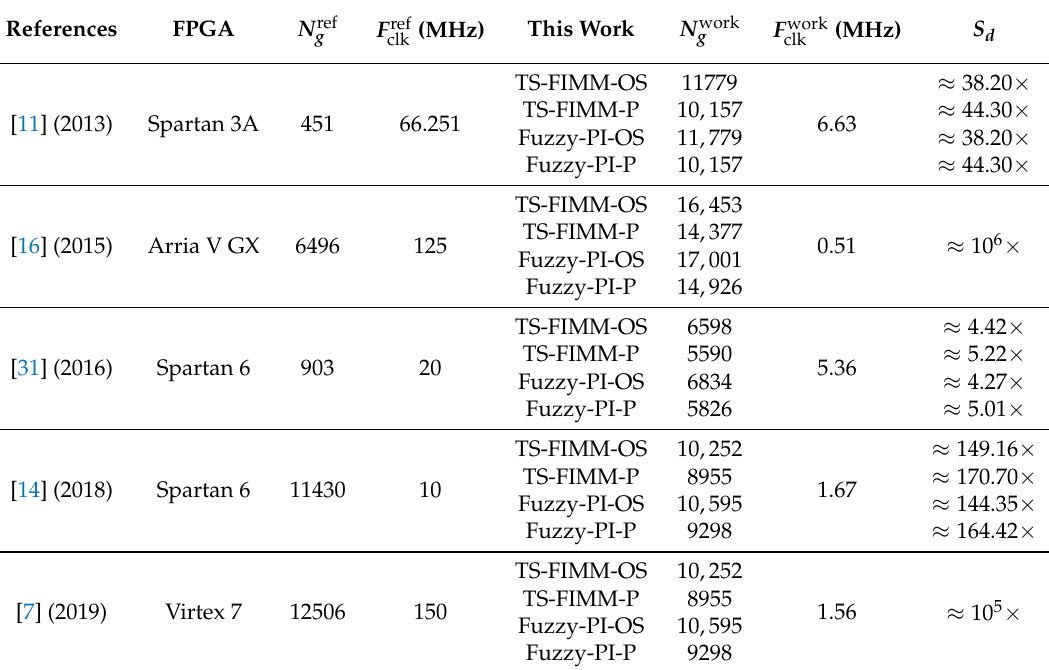
Table 9. Dynamic power comparison with other